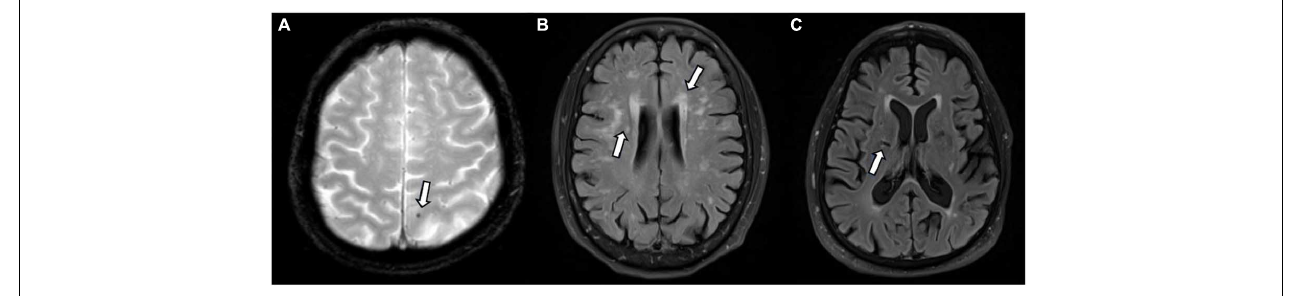
FIGURE 1 | Small vessel disease as identified on magnetic resonance imaging (MRI) by white arrows. (A) Microbleed identified on T2*; (B) white matter hyperintensities identified on FLAIR; (C) lacune on FLAIR.